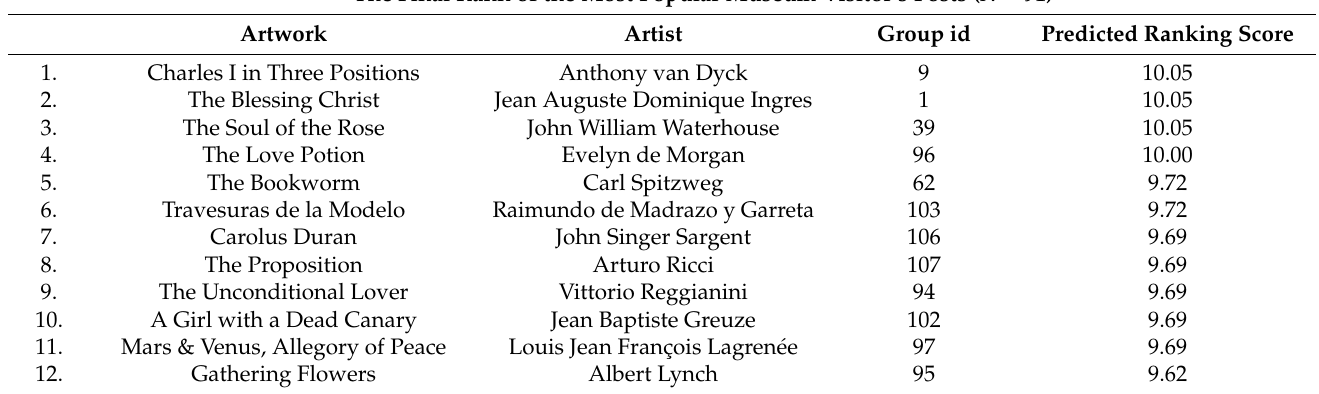
Table 6. The top 12 most popular museum artworks by ranking